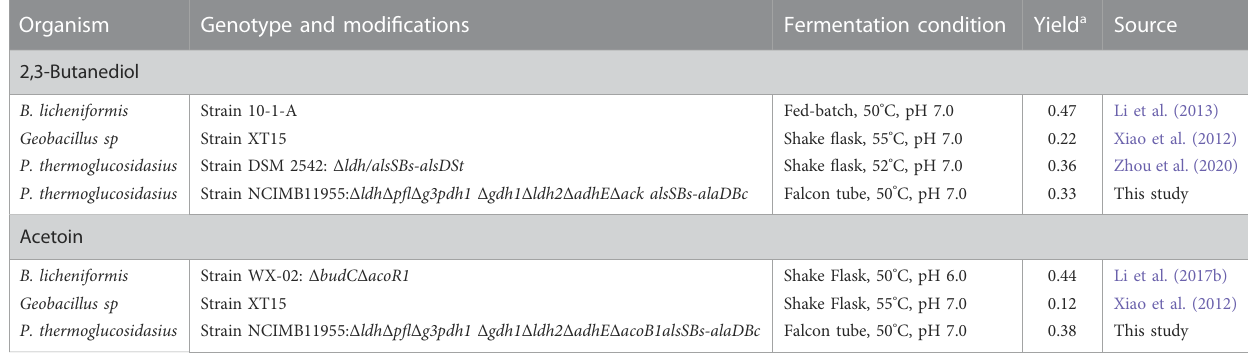
TABLE 1 Comparison of Acetoin and 2,3-butaneidol production by microorganisms at 50 ° C and above.